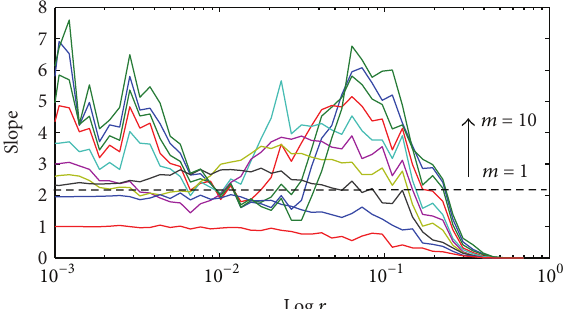
Figure 6: Local slope of correlation sum by longitudinal vibration time